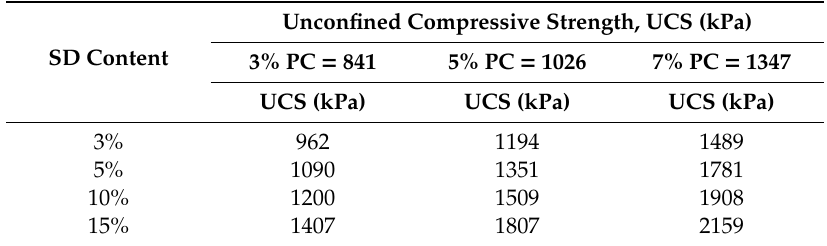
Table 8. UCS results before sulphate exposure in presence of SD (28 days curing).